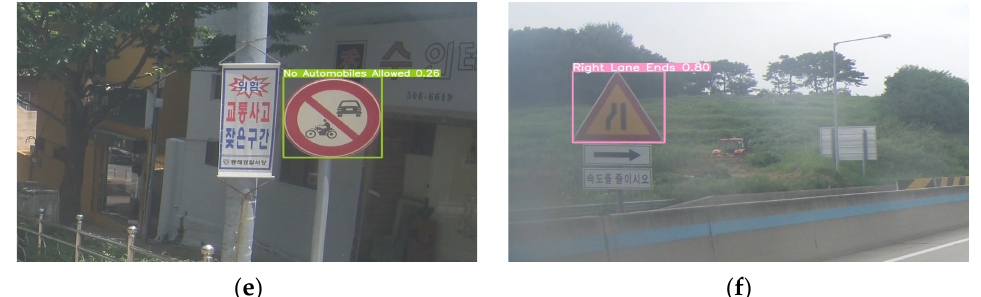
Figure 7. Examples of traffic sign recognition results in different types of light: ( a ) Sunlight (0.84), ( b ) Sunlight (0.89), ( c ) Tunnel (0.89), ( d ) Tunnel (0.89), ( e ) Sunlight (0.26), and ( f ) Natural light (0.80). Note that the numbers in the brackets indicate the minimum confidence score for the accurately recognized traffic signs in the examples.